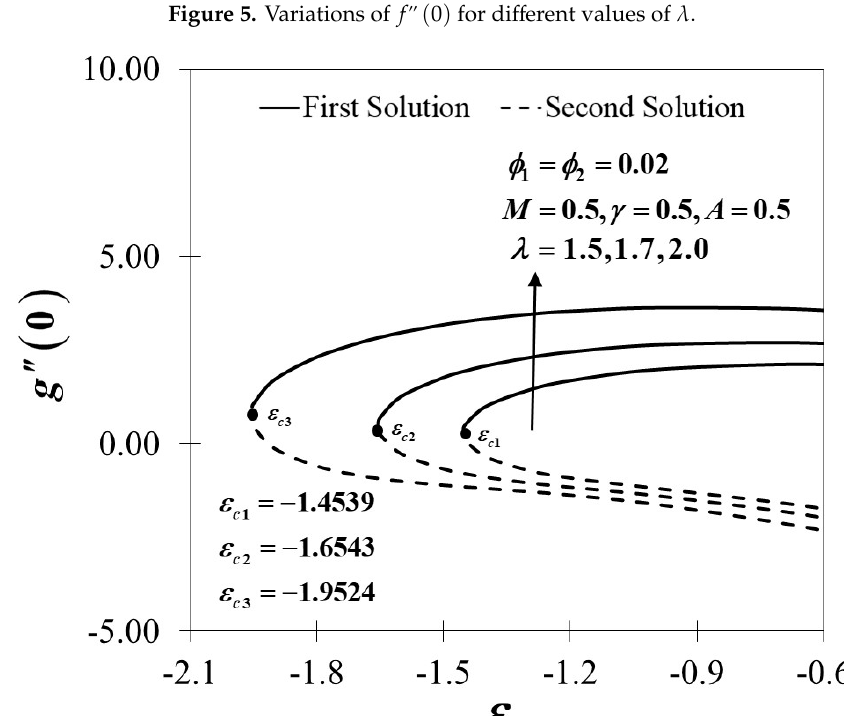
λ . Figure 5. Variations of f